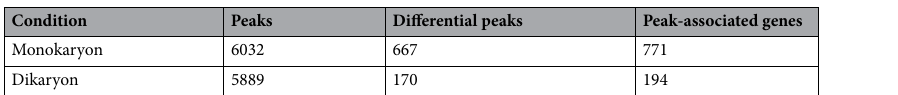
Table 2. Summary of peaks, differential peaks and associated genes for H3K4me2 ChIP during monokaryotic and dikaryotic development.